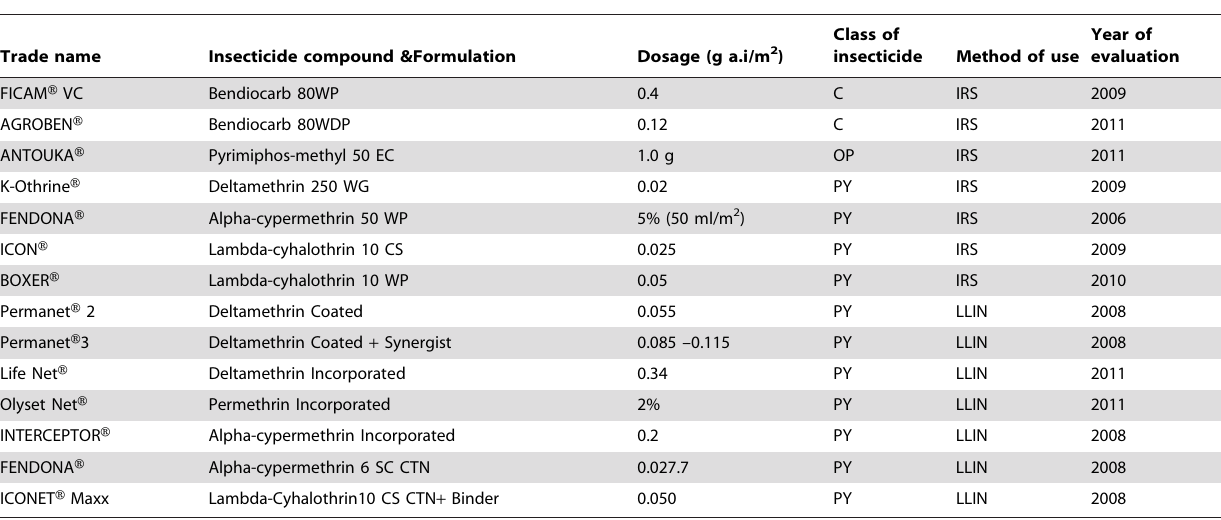
Table 1. Record of insecticide formulations and long lasting insecticidal nets tested between 2006 and